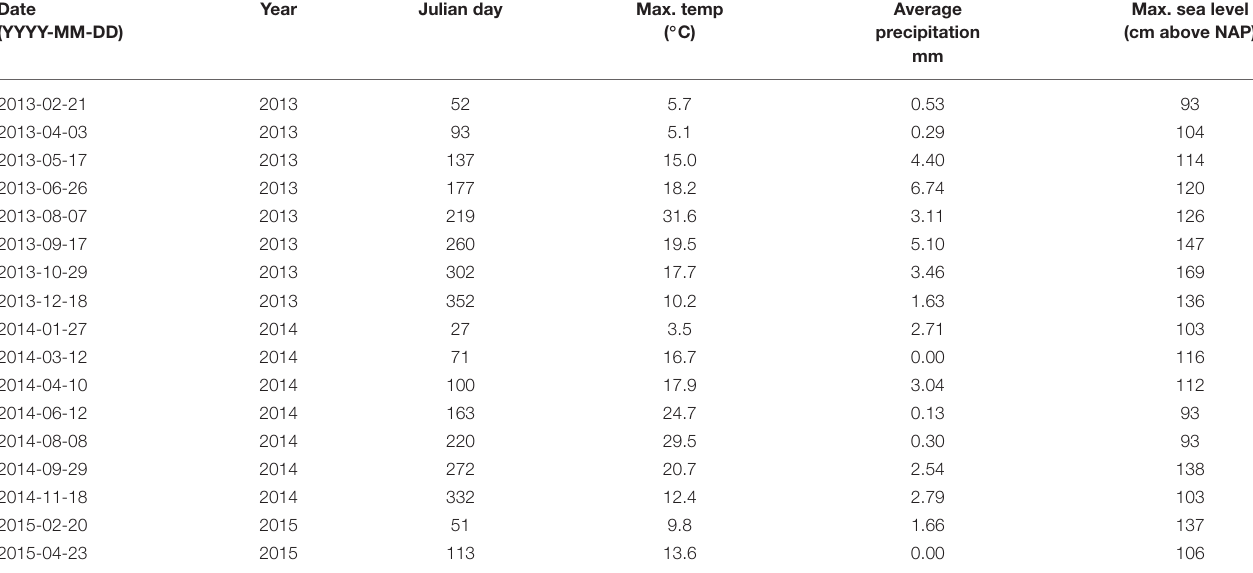
TABLE 1 | Sampling dates with related abiotic conditions.